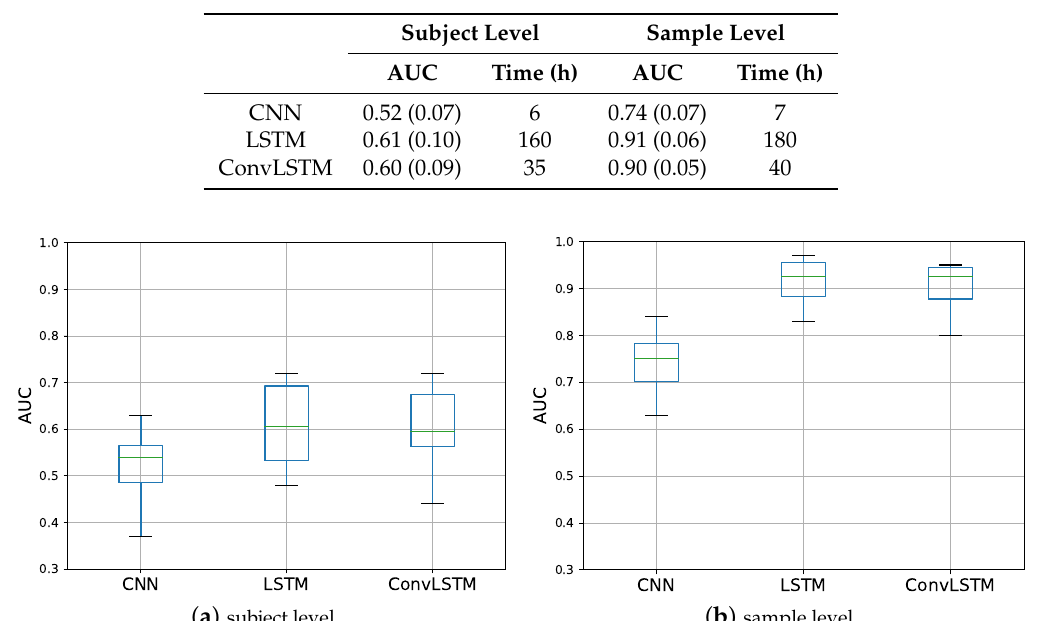
Table 2. Average AUC (standard deviation) and corresponding average training time per neural network (NN) architecture type for a subset of the data. The difference in training time between the ways of splitting the data is due to the slower convergence when splitting at the sample level.